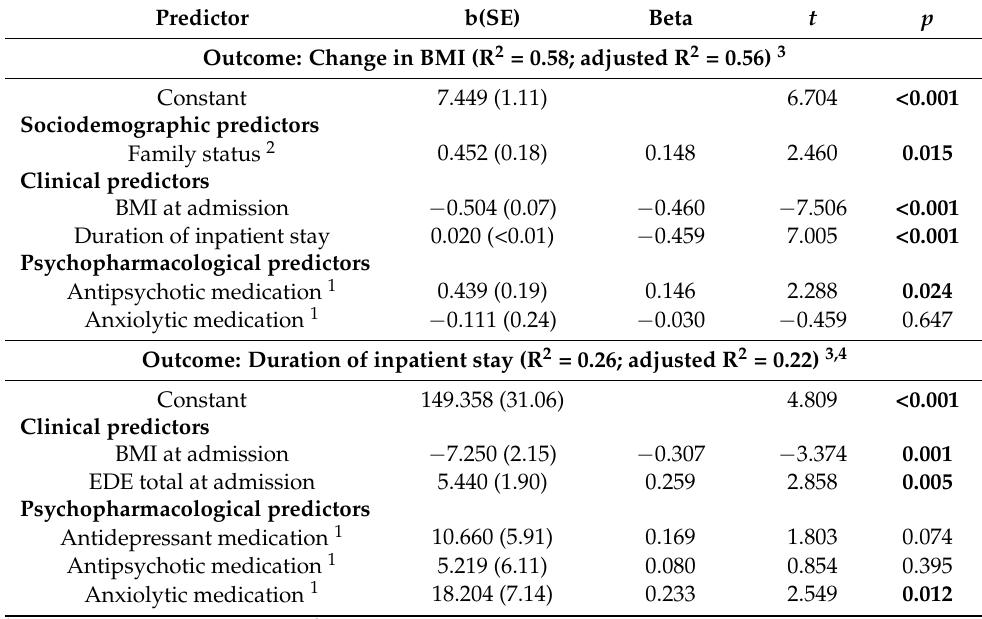
Table 4. Results of multivariate linear regression analyses predicting change in BMI and duration of inpatient